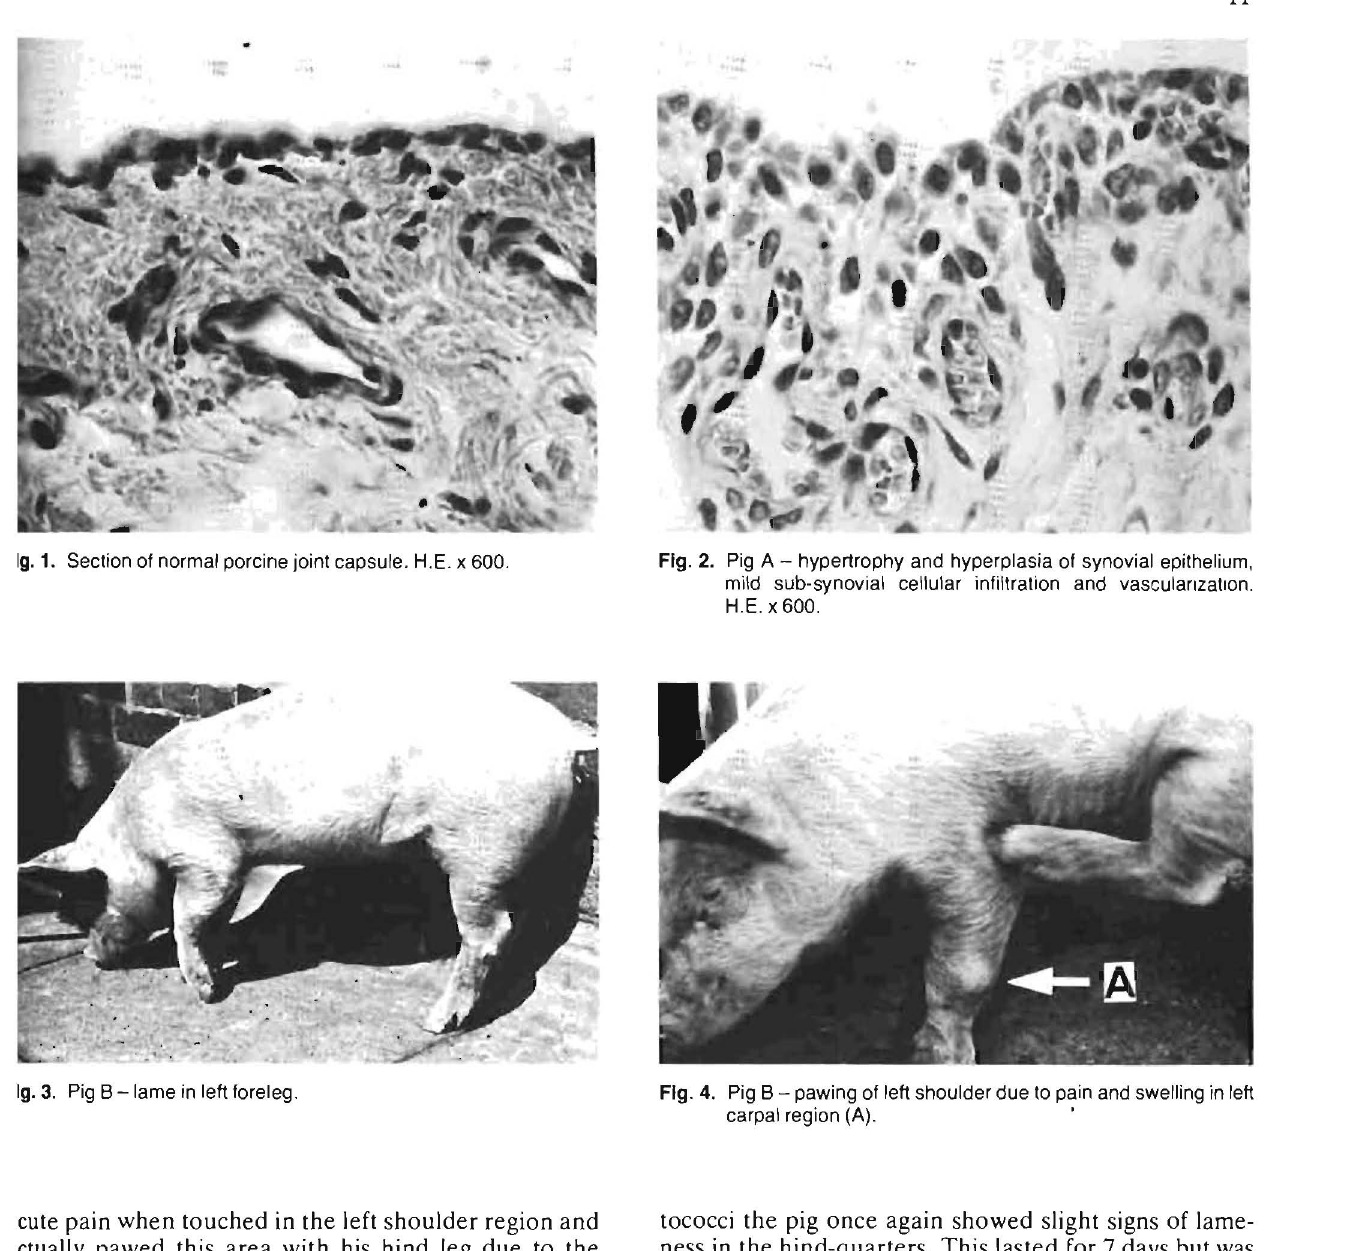
Fig. 2. Pig A - hypertrophy and hyperplasia of synovial epithelium, mild sub-synovial cellular infiltration and vascularization. HE x 600.